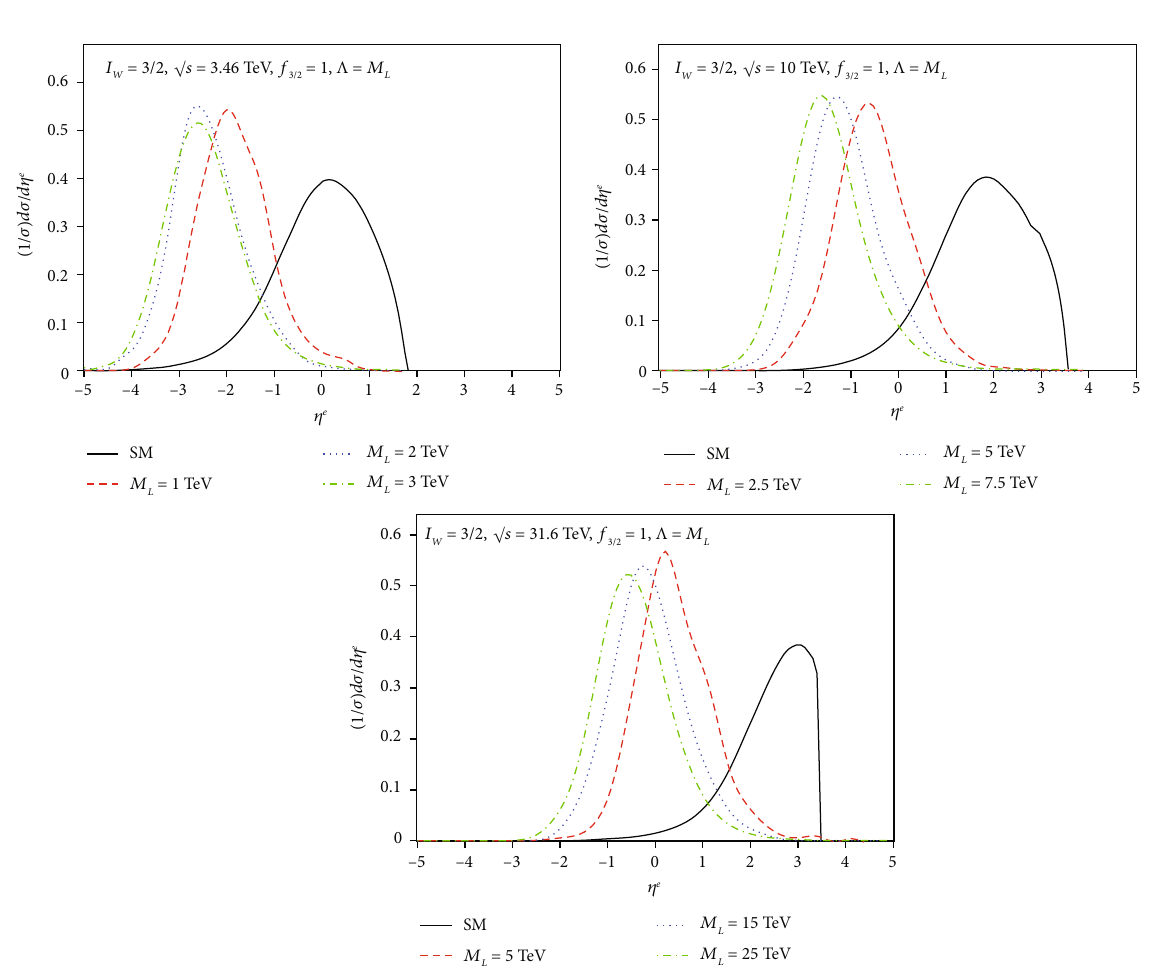
Figure 7: Normalized η distribution of the fi nal-state electron for the I